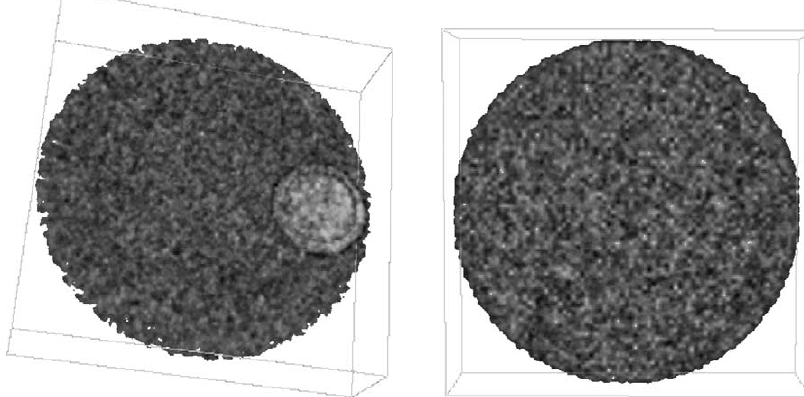
Fig. 2. Volume rendering of artificial 3D nuclei used to test 3D nuclear texture features. Left: image representing benign nucleus with normally distributed grey values and no nucleolus. Right: image representing malignant nucleus with the margination of the chromatin and a